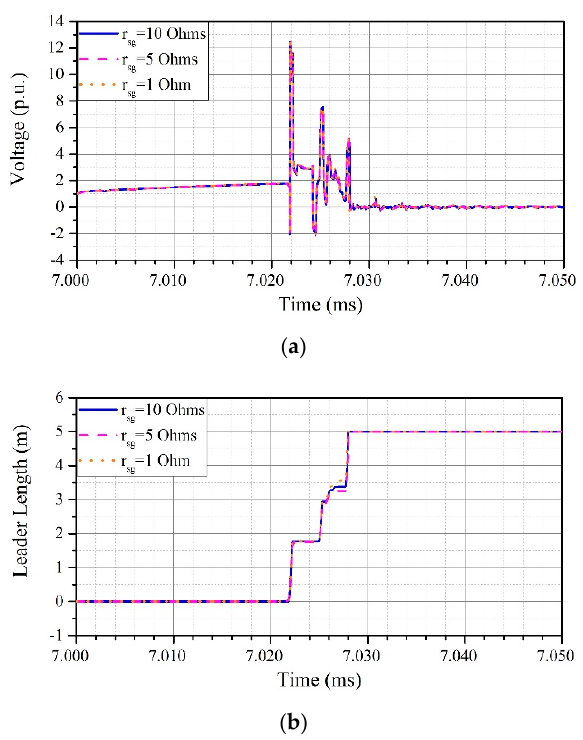
Figure 27. Lightning strike on the top of twr 2S . ( a ) Voltage across positive pole insulators of twr 2S according to sheath grounding impedance. ( b ) Leader growth between insulator gap of twr 2S according to sheath grounding impedance.